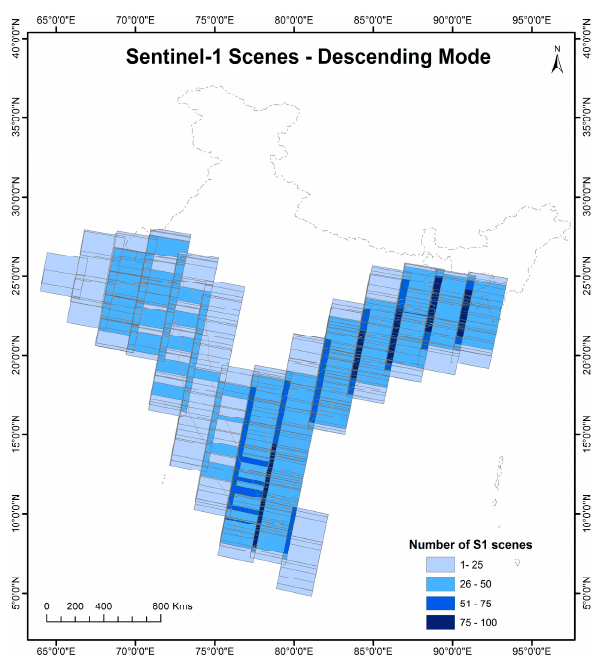
Figure 2. Coverage of VH Sentinel-1 time series data over the study area for the period of September 2014 to June 2017 in descending mode.